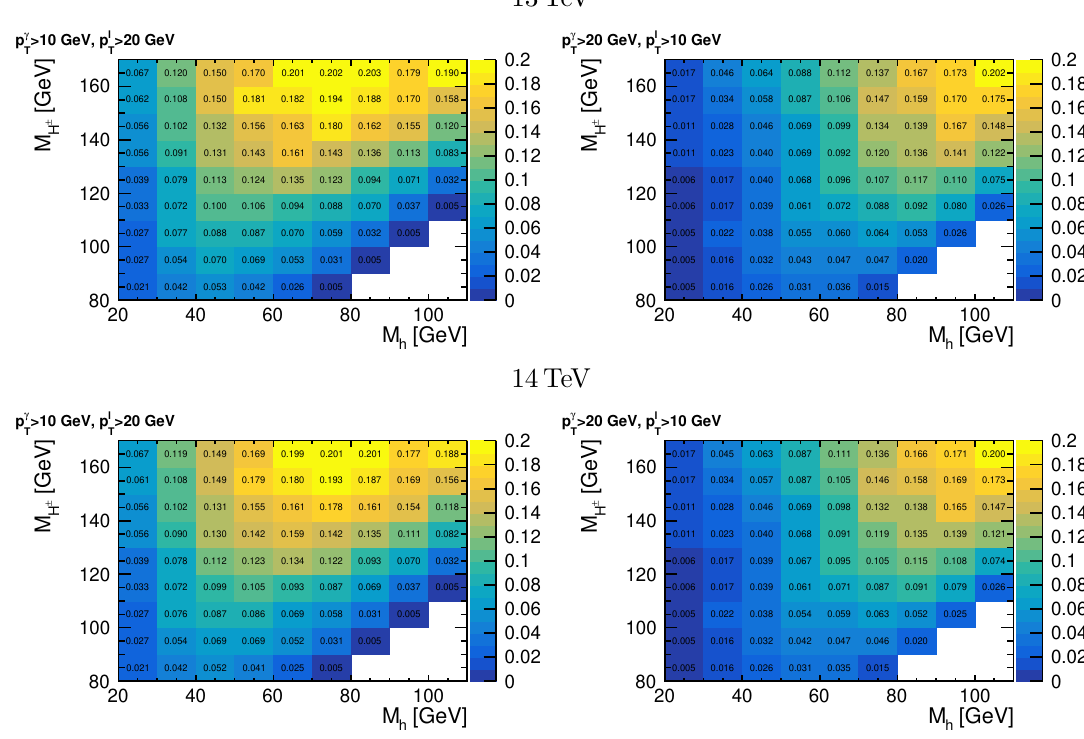
Figure 5 . Fiducial efficiency (cid:15) for detecting the signal via the ‘ν ‘ + 4 γ signature at detector level for the two sets of cuts given in eqs. (3.4) (left) and (3.5)